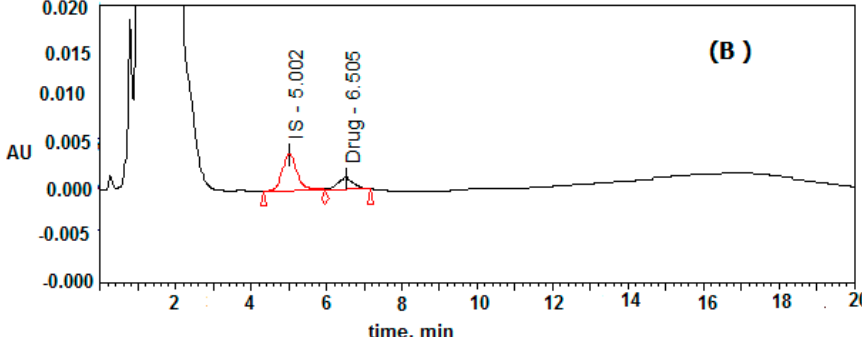
Figure 2. HPLC chromatogram of clonidine: ( A ) mouse plasma, ( B ) mouse plasma spiked with 1 µ g / mL (Tizanidine, IS) and 200 (ng / mL) of IS and clonidine respectively (retention time was 5.002 and 6.505 (min)).